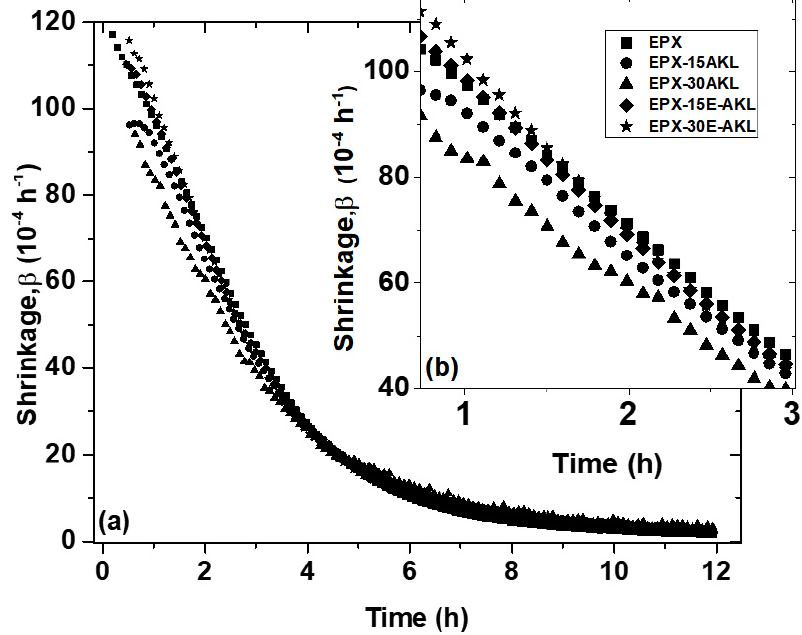
Figure 7. ( a ) Temporal evolution of the shrinkage coefficient (b, 10 − 4 ·h − 1 ) of all samples. Inset: ( b ) A zoomed-in representation of the early stages of the reaction (between 1 and 3 h).